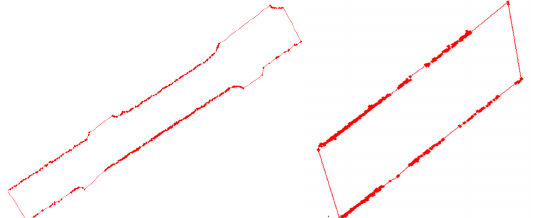
Figure 16. The closed curb polygon. Left: Auriga Dr. Right: Dalhousie St.